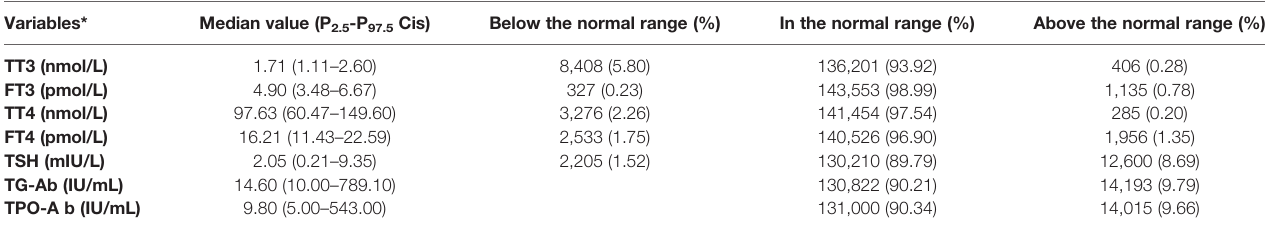
TABLE 1 | Distributions of serological thyroid function indicators for the 145,015 subjects. Variables* Median value (P 2.5 -P 97.5 Cis) Below the normal range (%) In the normal range (%) Above the normal range